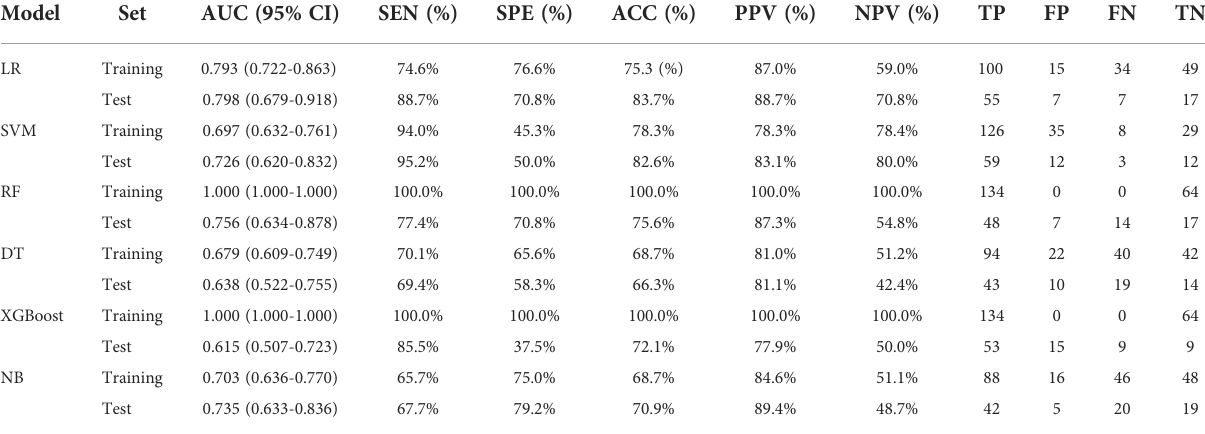
TABLE 3 Predictive performance of the six machine learning classi fi ers in the training and test sets. Model